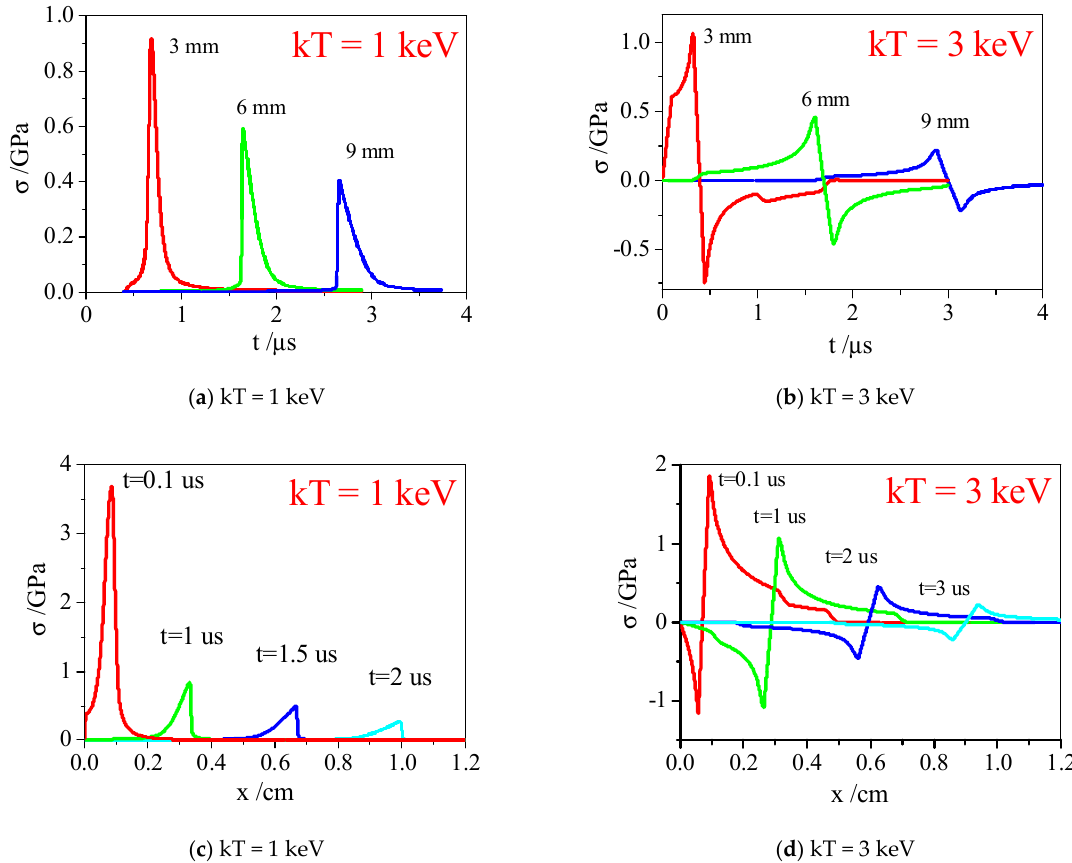
Figure 8. The stress wave along symmetry axis of C/P under radiation of X-ray with different blackbody spectra. ( a ) time distribution, kT = 1 keV; ( b ) time distribution, kT = 3 keV; ( c ) space distribution, kT = 1 keV; ( d ) space distribution, kT = 3 keV.